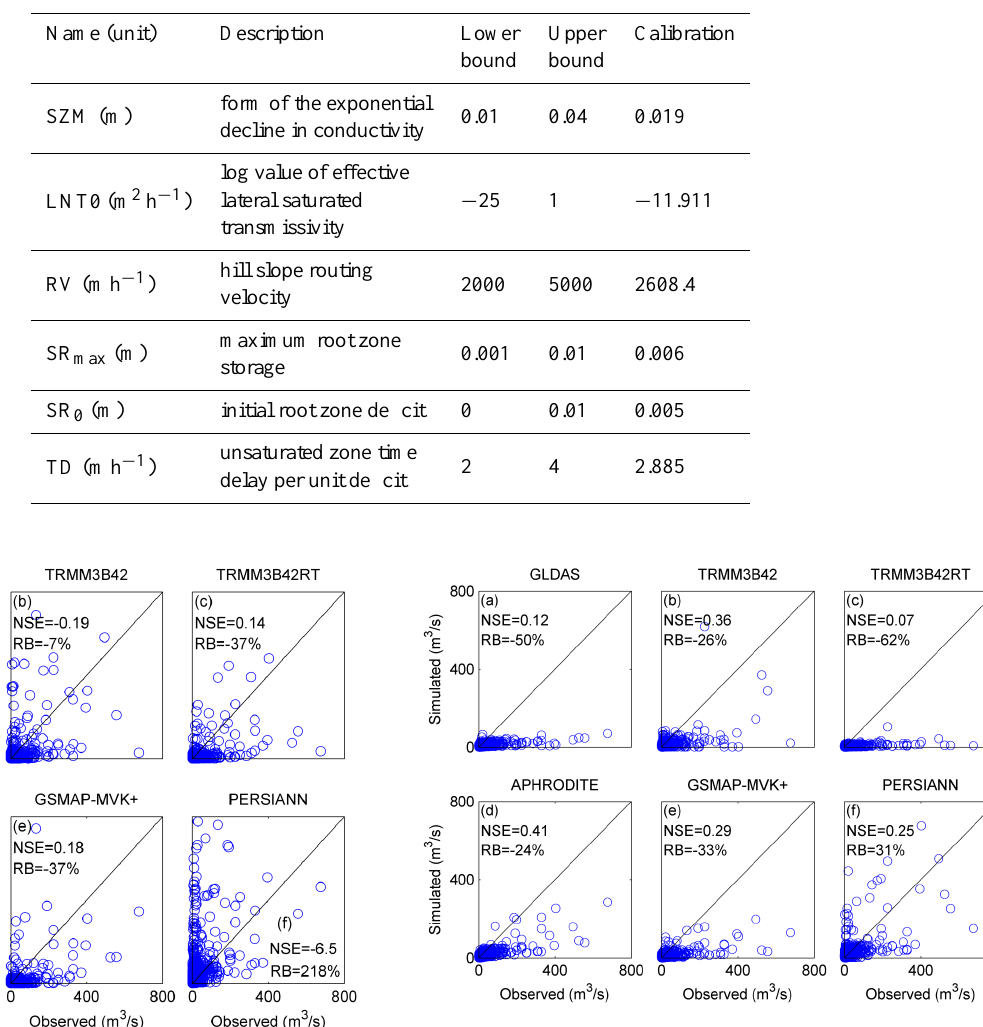
Table 3. TOPMODEL parameters.